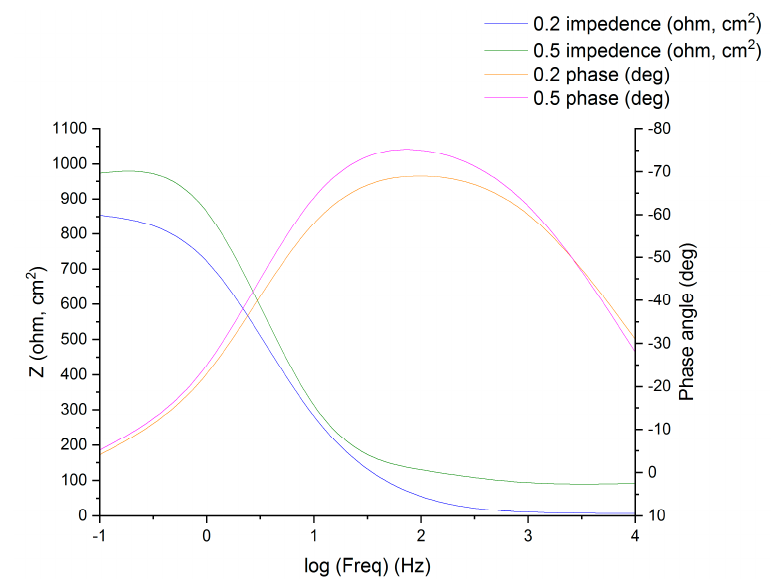
Figure 4. Experimental impedance and phase data in Bode format for mild steel in 1.0 N H 2 SO 4 containing the 0.5 mM corrosion inhibitor as denoted by the fitted line using the equivalent circuit.